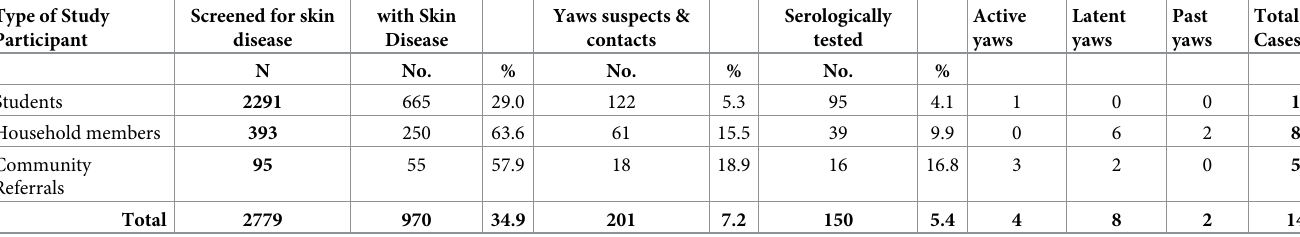
Table 3. Distribution of participants examined and yaws cases detected, by type of